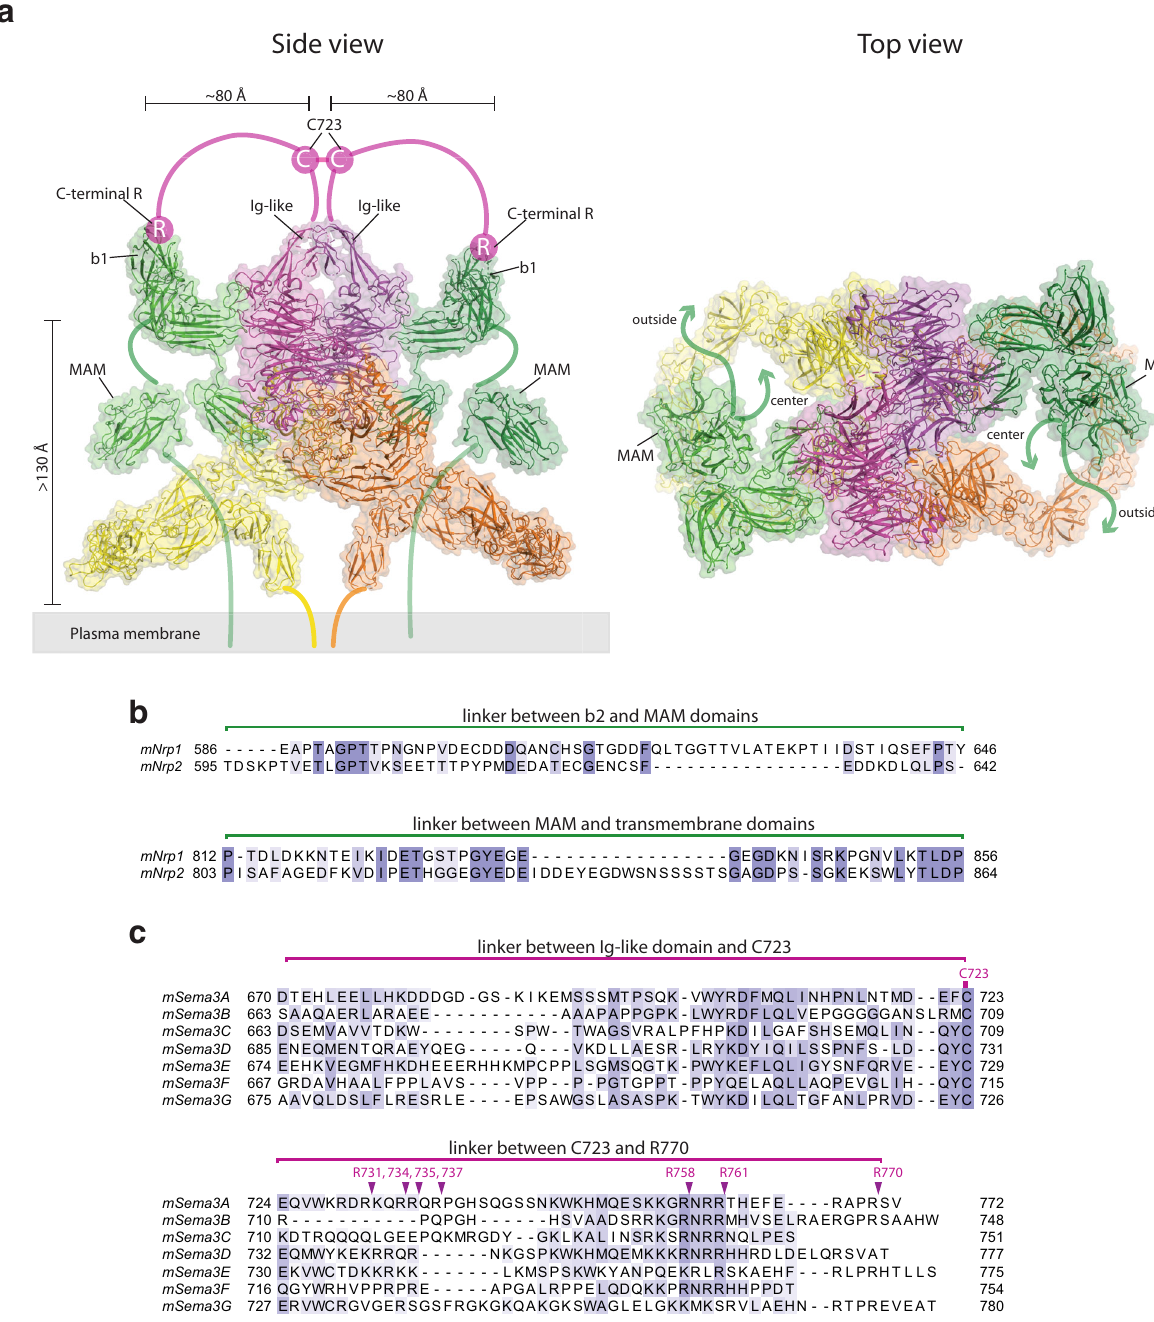
Fig. 2 Importance of the linker regions in the formation of the Sema3A/PlexinA4/Nrp1 complex. a Roles of the linkers in connecting various parts of the proteins in the tripartite complex on the cell surface. The crystal structure of the MAM domain of Nrp1 (PDB ID: 5l73) is docked between the a2b1b2 module and the plasma membrane. Thick lines represent the linker regions. The arrows in the right panel (top view) indicate that the MAM-linker region may use two alternative paths (through the center or outside of the PlexinA4 ring) to connect to the TM region of Nrp1. b Sequence alignment of the b2- MAM and MAM-TM linkers from mouse Nrp1 and Nrp2. c Sequence alignment of the tail regions of mouse class 3 semaphorins. Putative furin-cleavage sites are plasma membrane where both PlexinA4 and Nrp1 are anchored distance (over 130 Å). The MAM domain adopts a compact through their respective transmembrane regions (Fig. 1). As structure, with the distance between its N- and C-termini of shown in Fig. 2, the region following the b2 domain of neuropilin, ~30 Å 30 . Therefore, the b2-MAM and MAM-TM linkers must which includes the b2-MAM linker, the MAM domain and the cover ~100 Å distance to allow the formation of the semaphorin/ MAM-TM linker, could reach the transmembrane region by plexin/neuropilin complex on the cell surface (Fig. 2a). Consistent passing through the center of the PlexinA4 ring, or either side of with this requirement, the two linkers in both mouse Nrp1 and the ring. In both scenarios, this region needs to span a large Nrp2 are rather long, containing ~100 residues in total (Fig. 2b).